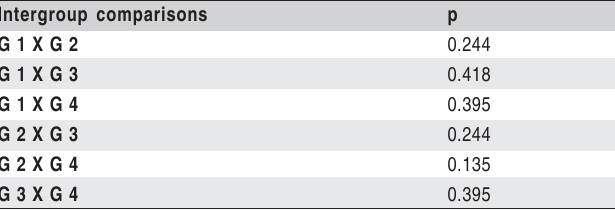
Fig. 2. Percent score distribution of the subjective evaluation of the experimental groups. Values within each bar indicate the number of observed scores in each Table 3: Comparison among the groups. Fisher’s exact test.